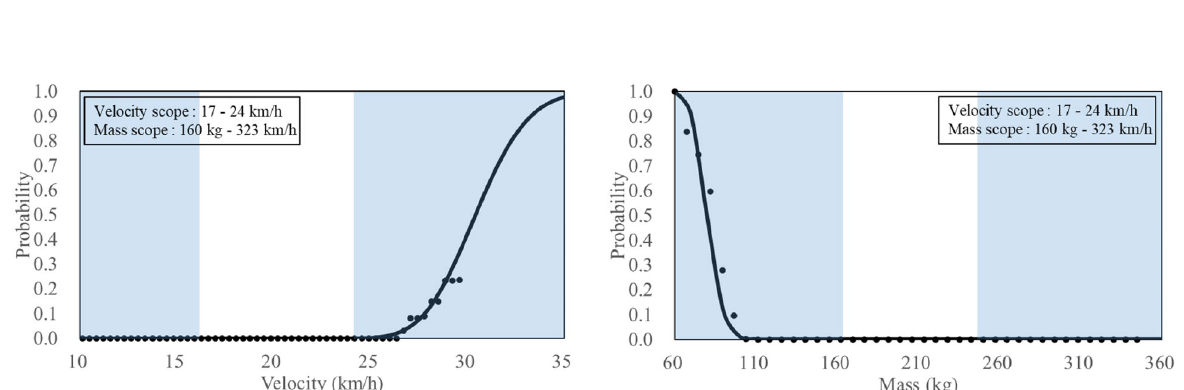
Figure 16. Presented fragility curves under same local impact energy 3.6 kJ (Mass and Travel distance).